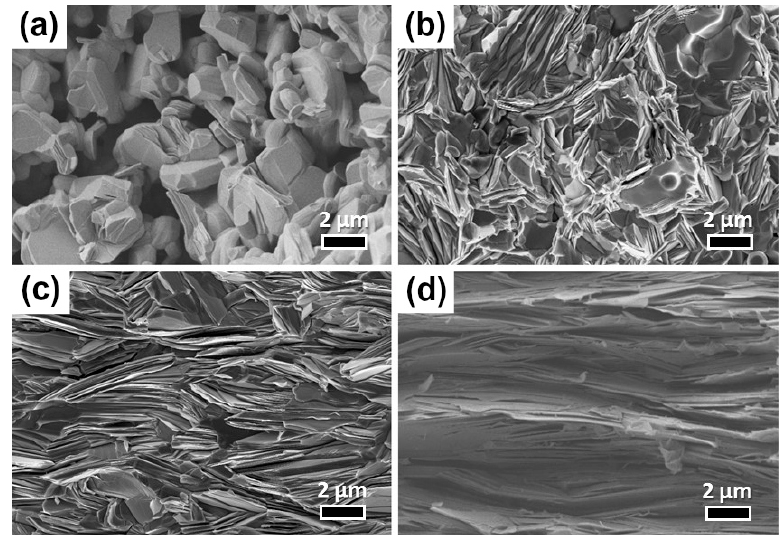
Figure 4. SEM micrographs of fractured surfaces parallel to the applied pressing axis of the Ca 3 Co 4 O 9 samples processed by ( a ) naturally sintered (NS), ( b ) SPS, ( c ) SPT, and ( d ) HP processes.